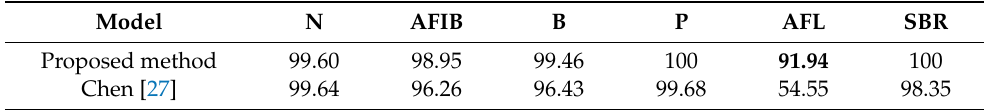
Table 8. Comparison of proposed and recent (Chen et al., 2020) methods for rhythms with similar